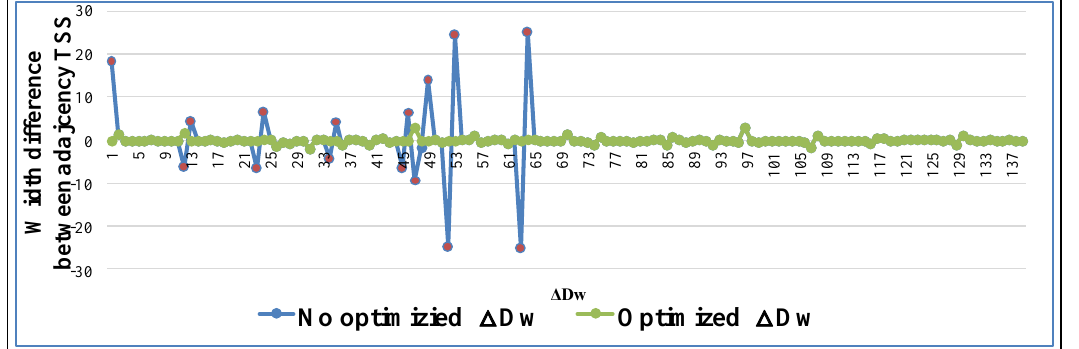
Figure 7. Width detection results